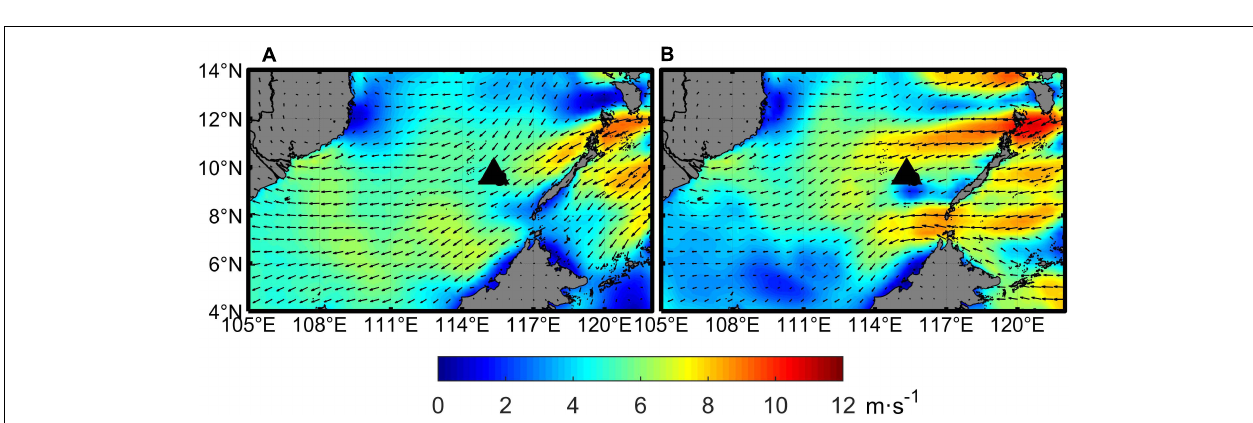
FIGURE 10 | Wind vectors (arrows) and speeds (shaded background color) (m/s) in the southern South China Sea on March 14 (A) and March 21 (B) . The black triangle is the mooring station.